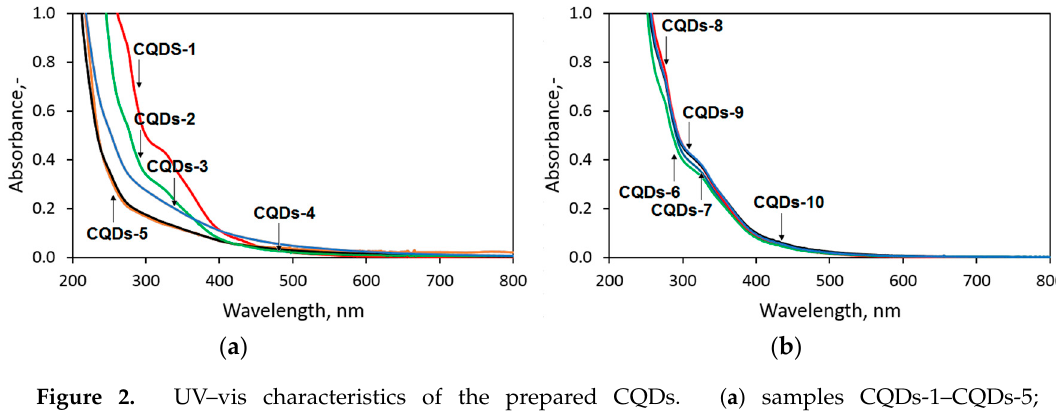
Figure 2. UV–vis characteristics of the prepared CQDs. ( a ) samples CQDs-1–CQDs-5; ( b ) samples